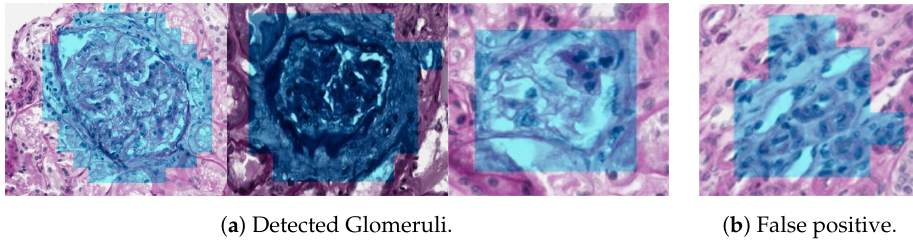
Figure 10. Example of correct and false positive detections. Regions detected as Glomerulus appear in blue color.